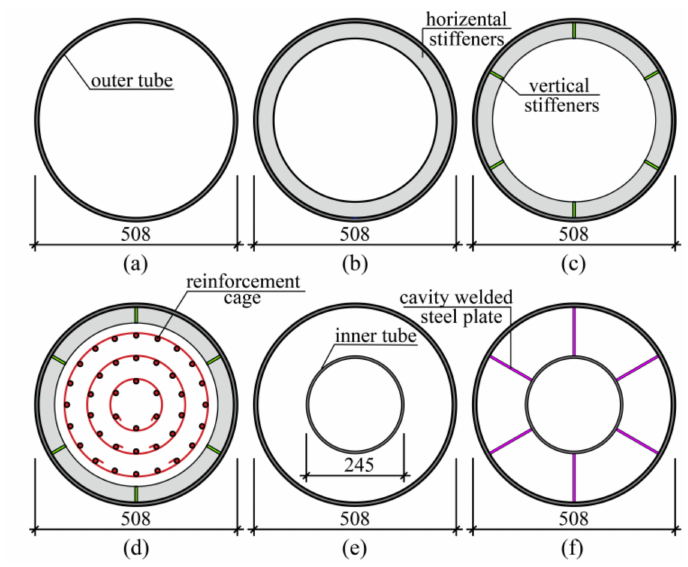
Figure 3. Cross sections of specimens. ( a ) CFST-N; ( b ) CFST-HS; ( c ) CFST-VS; ( d ) CFST-SR; ( e ) CFST-DT; and ( f ) CFST-MC.